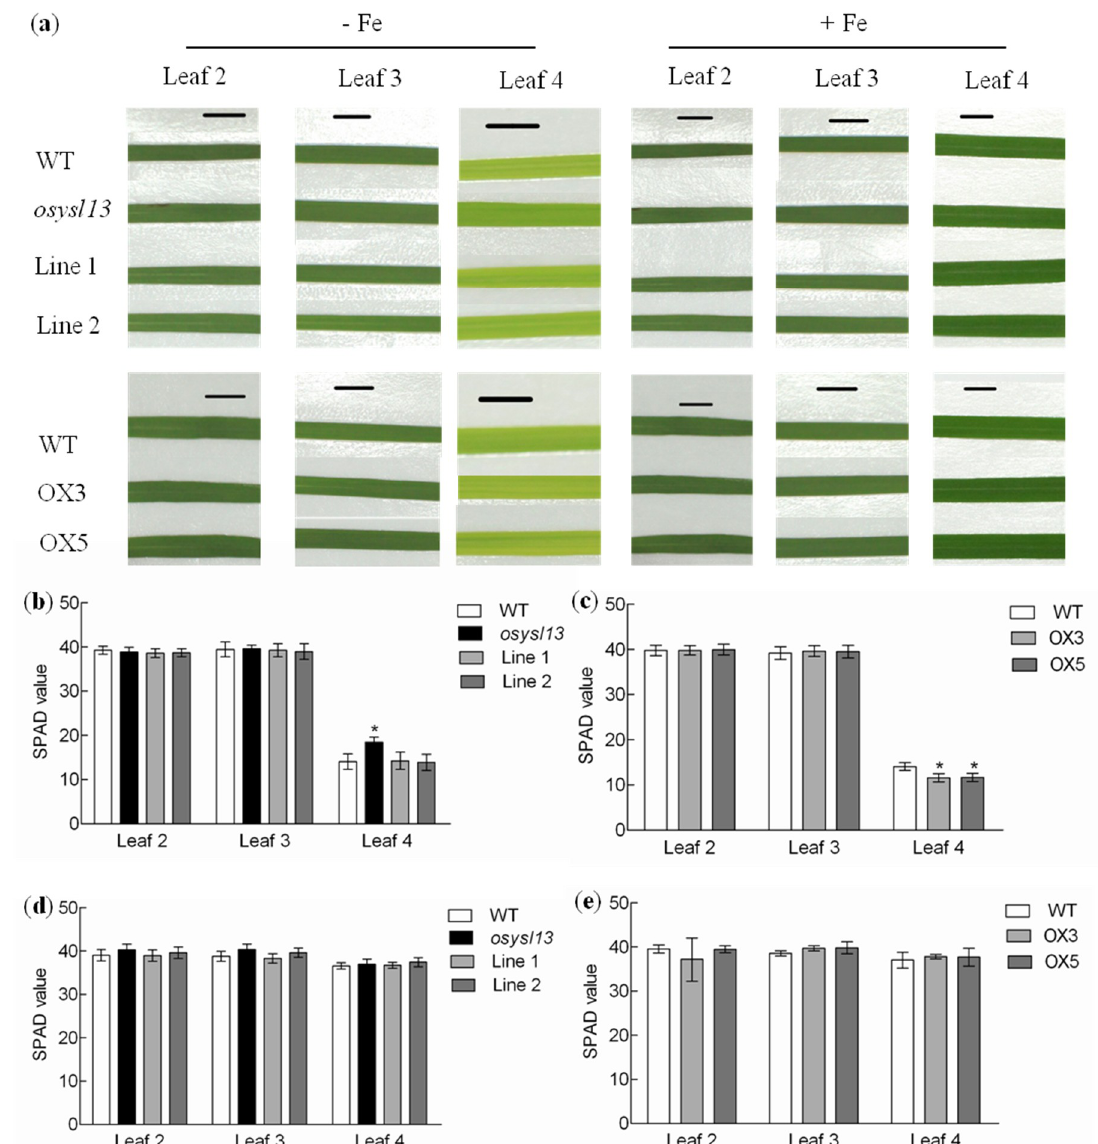
Figure 5. Phenotypic analysis of the osysl13 mutant, the complementation lines (Line 1 and 2), wild type and OsYSL13 overexpression lines (OX3 and OX5). ( a ) The fully expanded leaves of the plant materials during Fe deficiency (shown in the left) and sufficiency (shown in the right). Plants were grown in nutrient solution with or without Fe for 10 days. There were 5 leaves in each of these plant materials and the fifth leaf was not fully expanded. Scale bars = 0.5 cm. ( b – e ) The soil and plant analyzer development (SPAD) values of different leaves. ( b , d ) SPAD values of the different leaves in the osysl13 mutant, wild-type, and complementation lines during Fe deficiency ( b ) and sufficiency ( d ). ( c , e ) SPAD values of different leaves in the OsYSL13 overexpression lines and wild type during Fe deficiency ( c ) and sufficiency ( e ). The SPAD values were measured by the portable chlorophyll meter. It was difficult to measure the SPAD values of the unexpanded leaves. Significant differences compared with the wild type were determined by ANOVA (* p < 0.05). Data were shown as means ± SD ( n = 3).